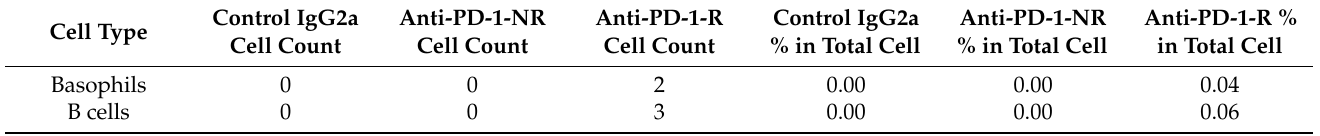
Table 1. The cell counts and percentages of the immune subsets in all